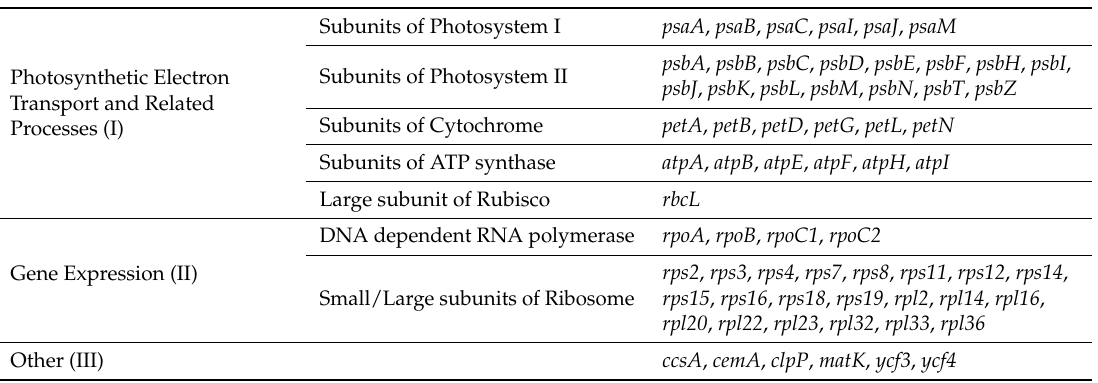
Table 3. The 65 protein-coding genes in 45 representative species were extracted from NCBI for construction of the phylogenetic trees [24]. Nucleotides were translated into amino acids using Geneious [59]. Amino acid sequence homologies were aligned by MUSCLE [60]. Aligned genes were concatenated into functional categories